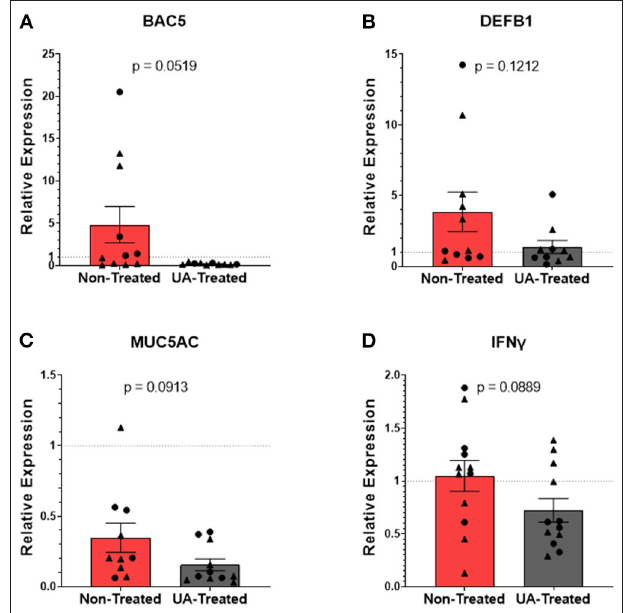
FIGURE 5 | Prophylactic UA treatment alters expression of innate defense genes in the lungs following MH infection. Samples of lung tissue were collected at necropsy and stored in RNAlater solution for qPCR analysis of (A) BAC5, (B) DEFB1, (C) MUC5AC, and (D) IFN γ mRNA expression; individual animal data from F2019 has been represented as a circle (•), while S2020 animal data has been represented as a triangle ( N ). The relative mRNA expression in pneumonic lung tissue from non-treated and UA-treated animals was compared to healthy lung tissue from control animals (F2019 group) for both studies. The average relative expression (RE) ± the SEM for each treatment group across both studies is depicted. Outliers in the data sets were first identified using the ROUT method (Prism v9.1.0), and the data were analyzed using a standardized unpaired t -test (* p < 0.05). (A) Non-treated n = 11, UA-treated n = 10; (B) non-treated n = 11, UA-treated n = 10; (C) non-treated n = 10, UA-treated n = 11; (D) non-treated n = 12, UA-treated n =